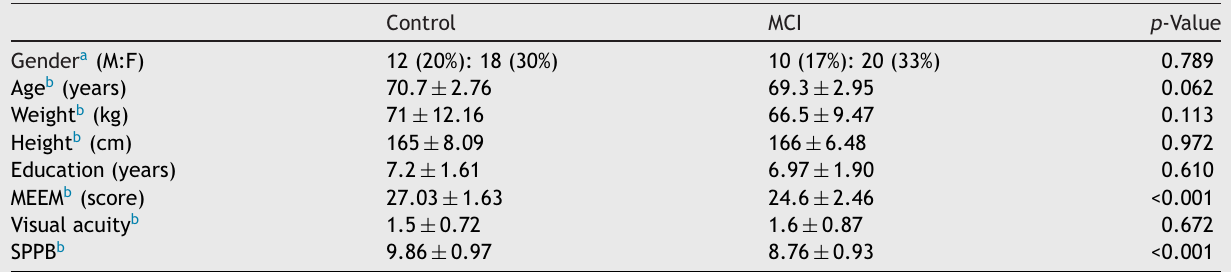
Table 1 Demographic and anthropometric characteristics, MMSE scores, and physical and functional characterization in diag- nostic